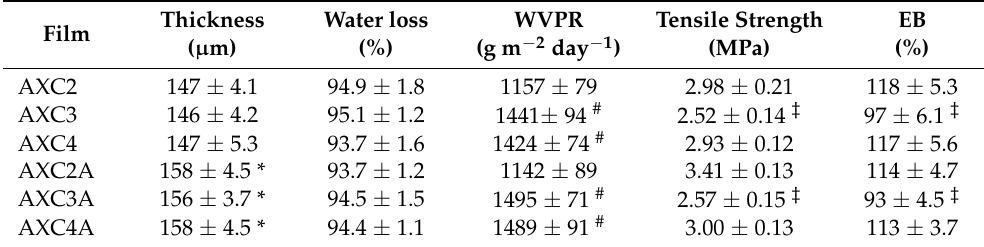
Table 2. Thickness, water loss, mechanical strength and water vapor permeation rate (WVPR) of the AX-CMC composite films (mean ± SD, n =